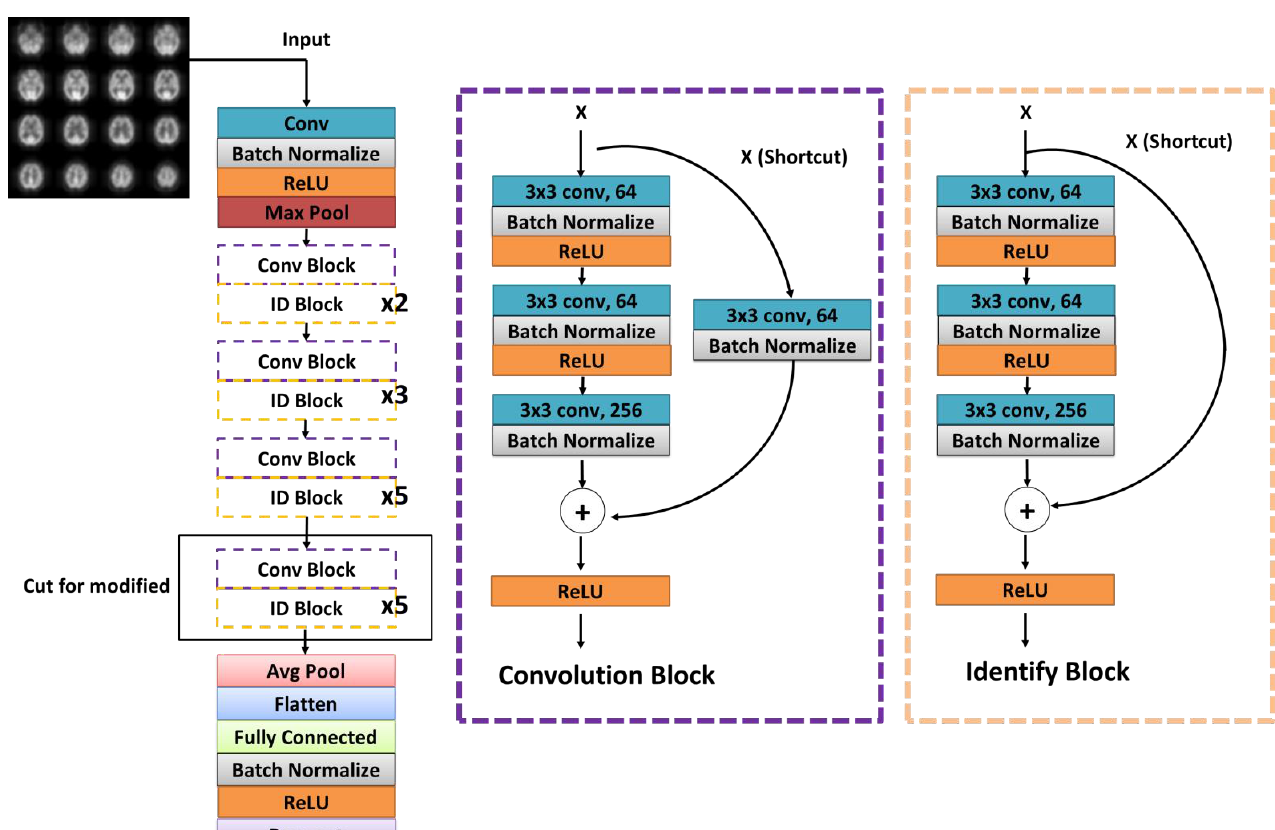
Figure 2. The convolutional neural network architecture, ResNet-50, used in this study.